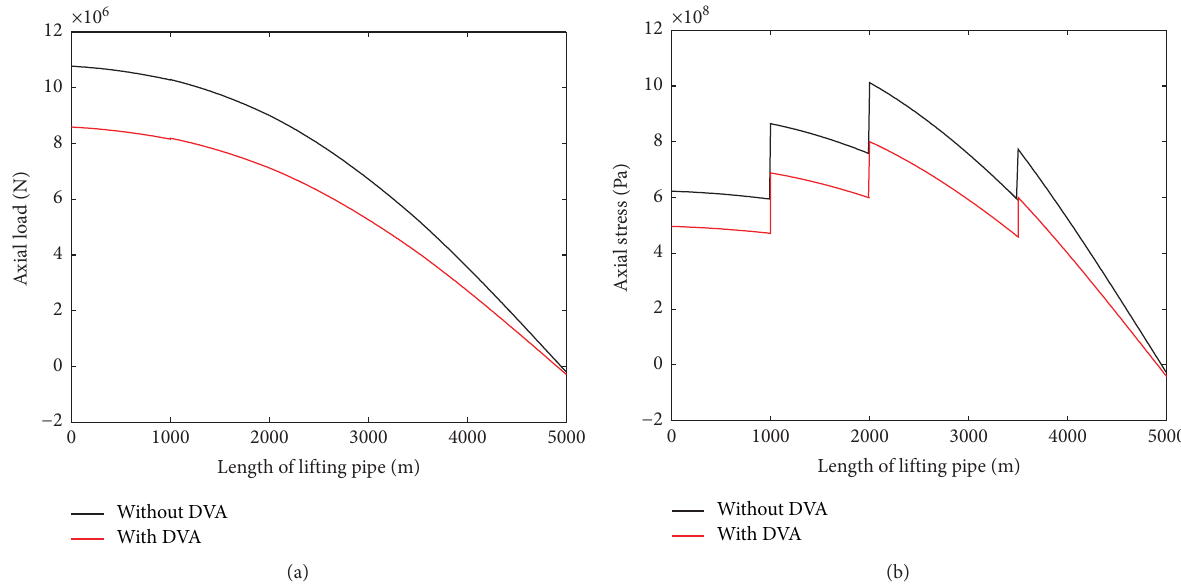
Figure 15: Dynamic load and stress with/without DVA. (a) Axial load. (b) Axial stress.